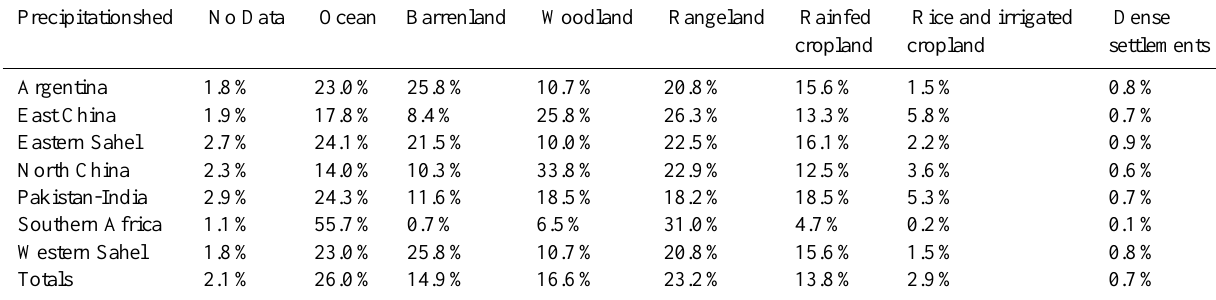
Table 3. Land use within the seven precipitationsheds, using the reclassified Anthromes. Precipitationshed No Data Ocean